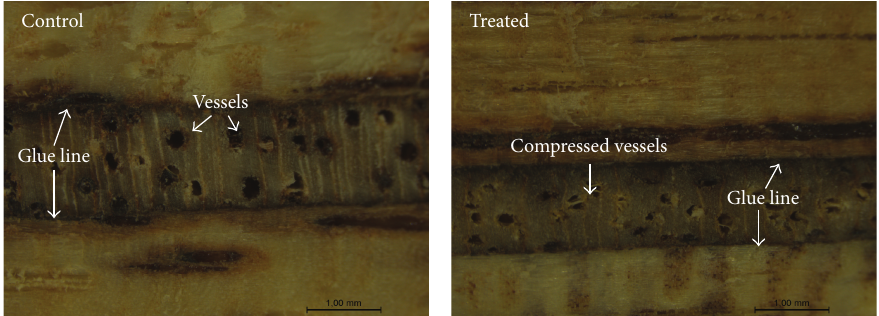
Figure 1: Stereomicroscopy (20x) images for general analysis of plywood densification and glue line. Scale: 1.0mm.